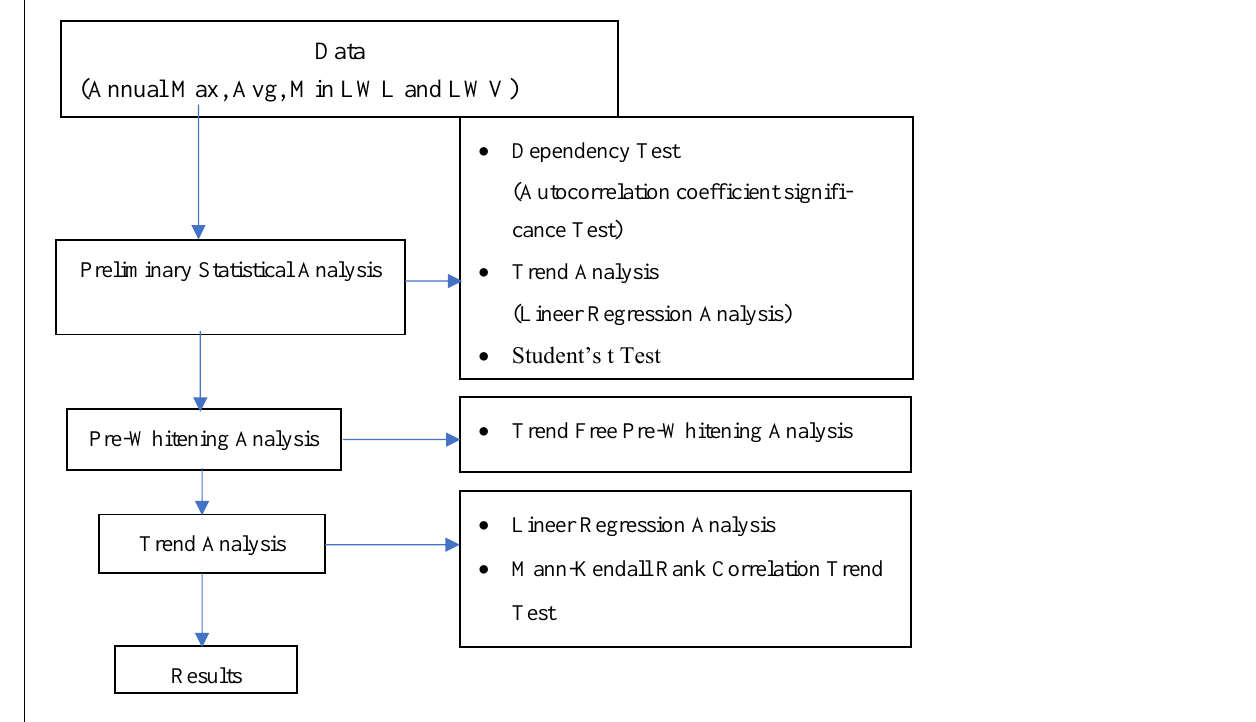
Figure 2. Working flow chart.